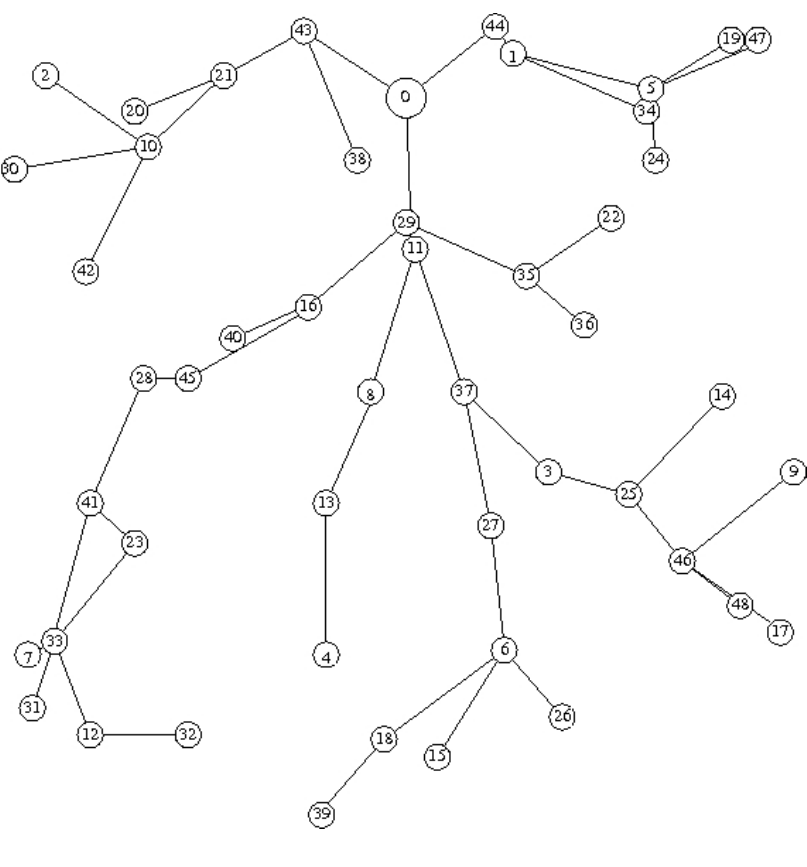
Figure 8. Topology of 49 nodes and a density 8 selected for delay evaluation.